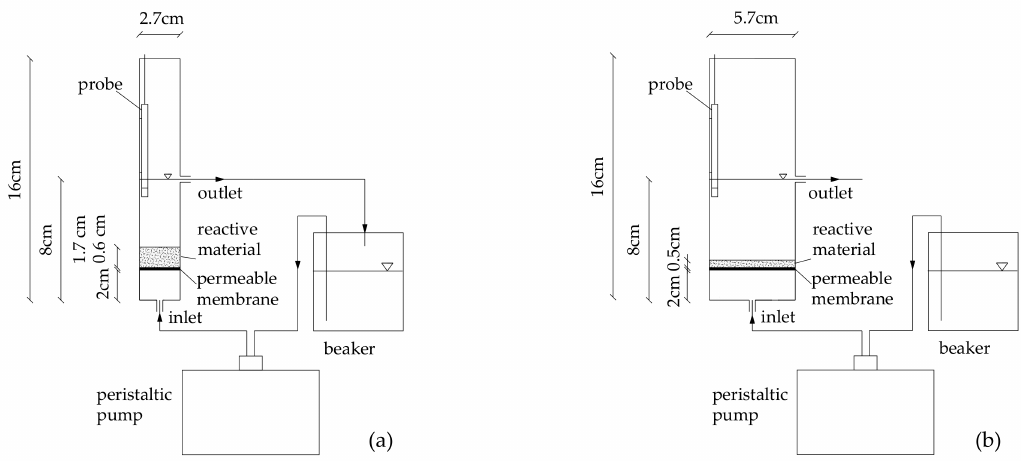
Figure 1. Schemes of the systems used for batch tests (the depth of reactive material in the column was 1.7 cm and 0.6 cm for nanoscopic zero-valent iron supported on magnesium oxide grains (MgO_nZVI) and microscopic zero-valent iron (mZVI), respectively) ( a ) and continuous tests ( b